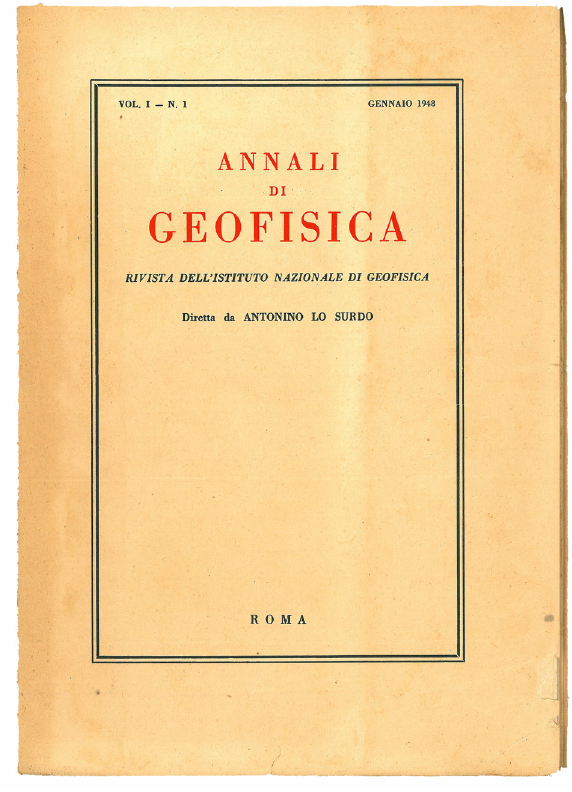
Figure 1. First issue of Annali di Geofisica,